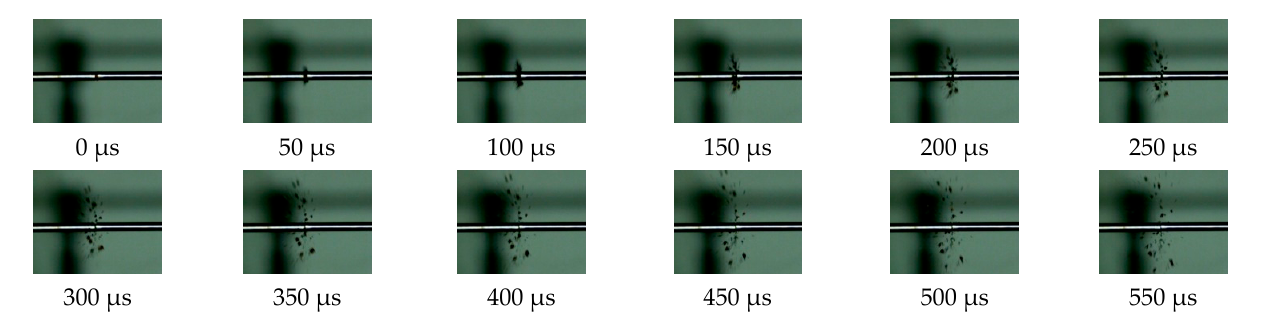
Figure 8. PLA ‐ Cu crushing (Strain rate is 4150 s − 1 ). Figure 8. PLA-Cu crushing (Strain rate is 4150 s − 1